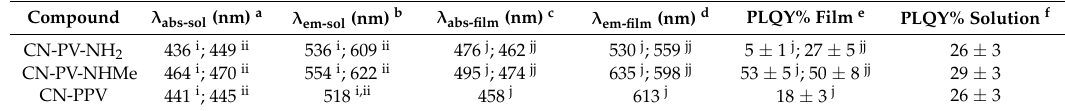
Table 1. Optical data of synthesized compounds.